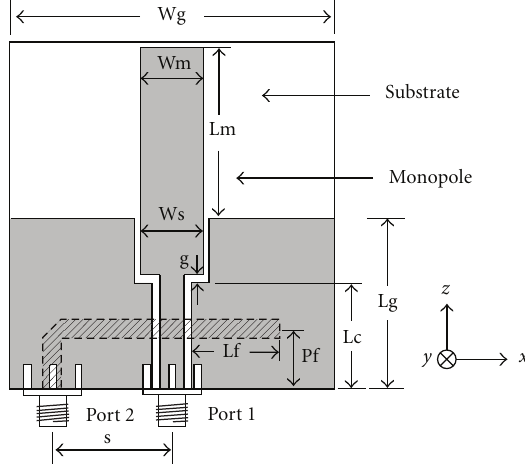
Figure 2: Sketch map of proposed antenna.